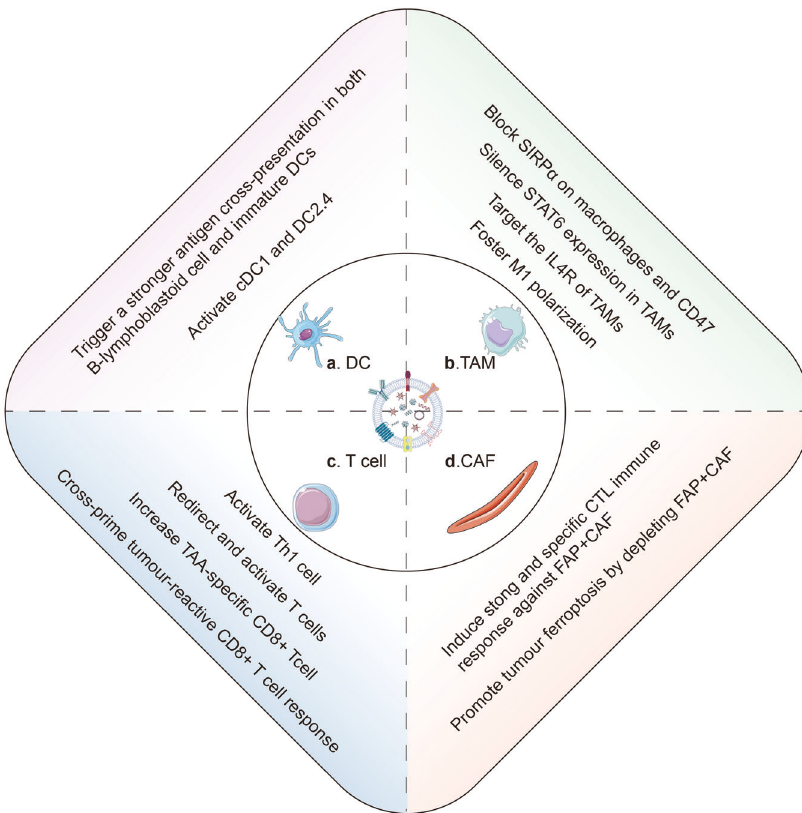
Fig. 5 The engineered exosomes remodel the suppressive tumor microenvironment. a The internalization of engineered exosomes not only activates cDC1 and DC2.4, but also trigger a stronger antigen cross-presentation in both B-lymphoblastoid cells and monocyte-derived immature DCs. b Generally, the engineered exosomes reprogram tumor-associated macrophages from M2 to M1. Besides, the SIRP α and CD47 on macrophage could be blocked by the engineered exosomes. Speci fi cally, exoASO-STAT6 could selectively silence STAT6 expression in TAMs. c In TNBC, engineered exosomes could prime and trigger T cells toward killing EGFR-positive TNBC. Additionally, the engineered exosomes could expand and cross-prime TAA-speci fi c CD8 + T cells and activate Th1 cells. d Engineered exosomes induce strong and speci fi c CTL immune response against tumor cells and FAP + CAFs. Furthermore, by releasing IFN- γ and depleting FAP + CAFs, the engineered exosomes could promote tumor